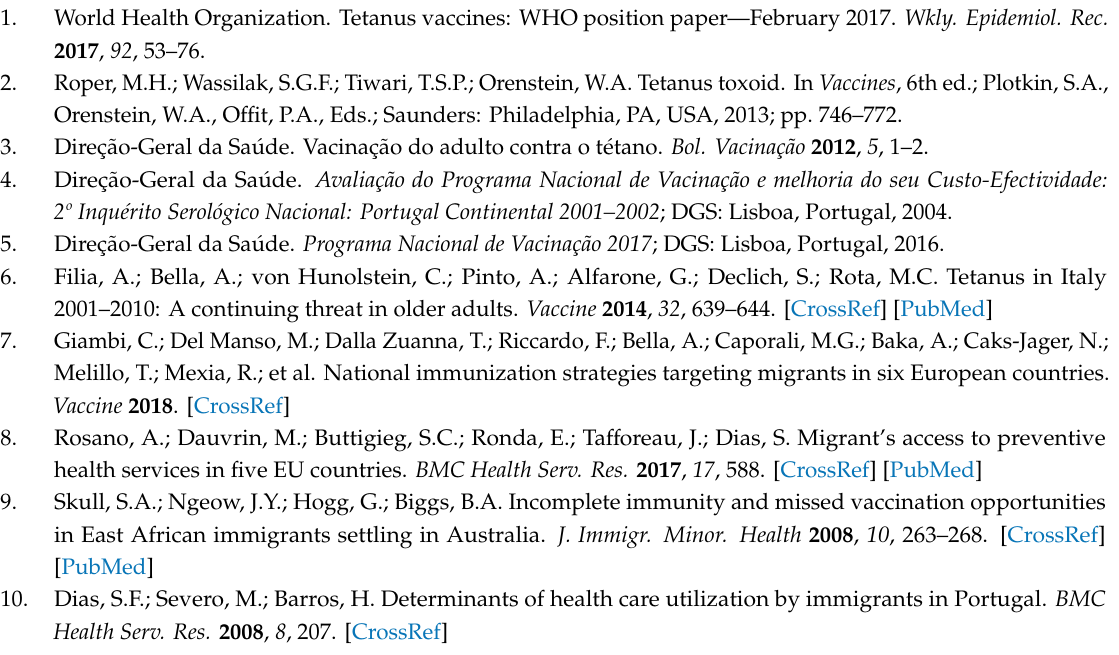
Table S1: Self-reported tetanus vaccination coverage by country of birth among adults ( ≥ 18 years of age) living in Portugal, National Health Survey